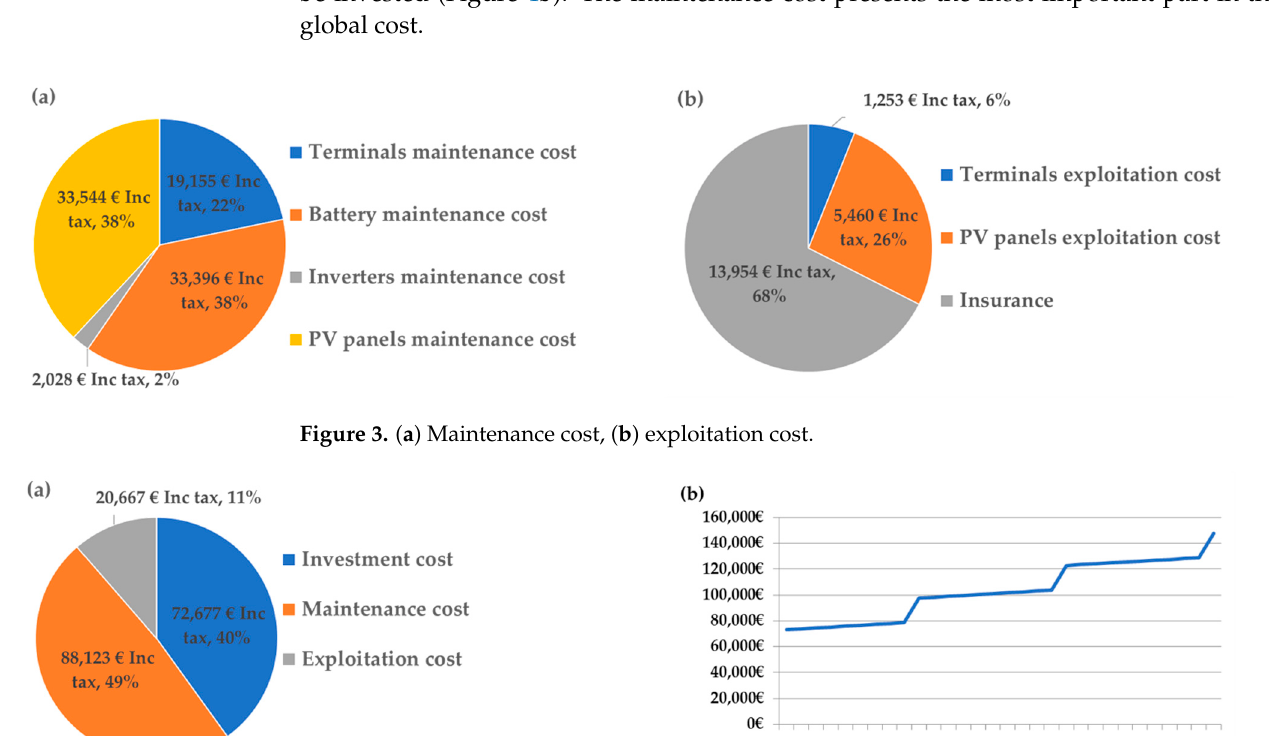
Figure 4. The 30-year financial report: ( a ) Distribution of the global cost; ( b ) evolution of the global cost by year.